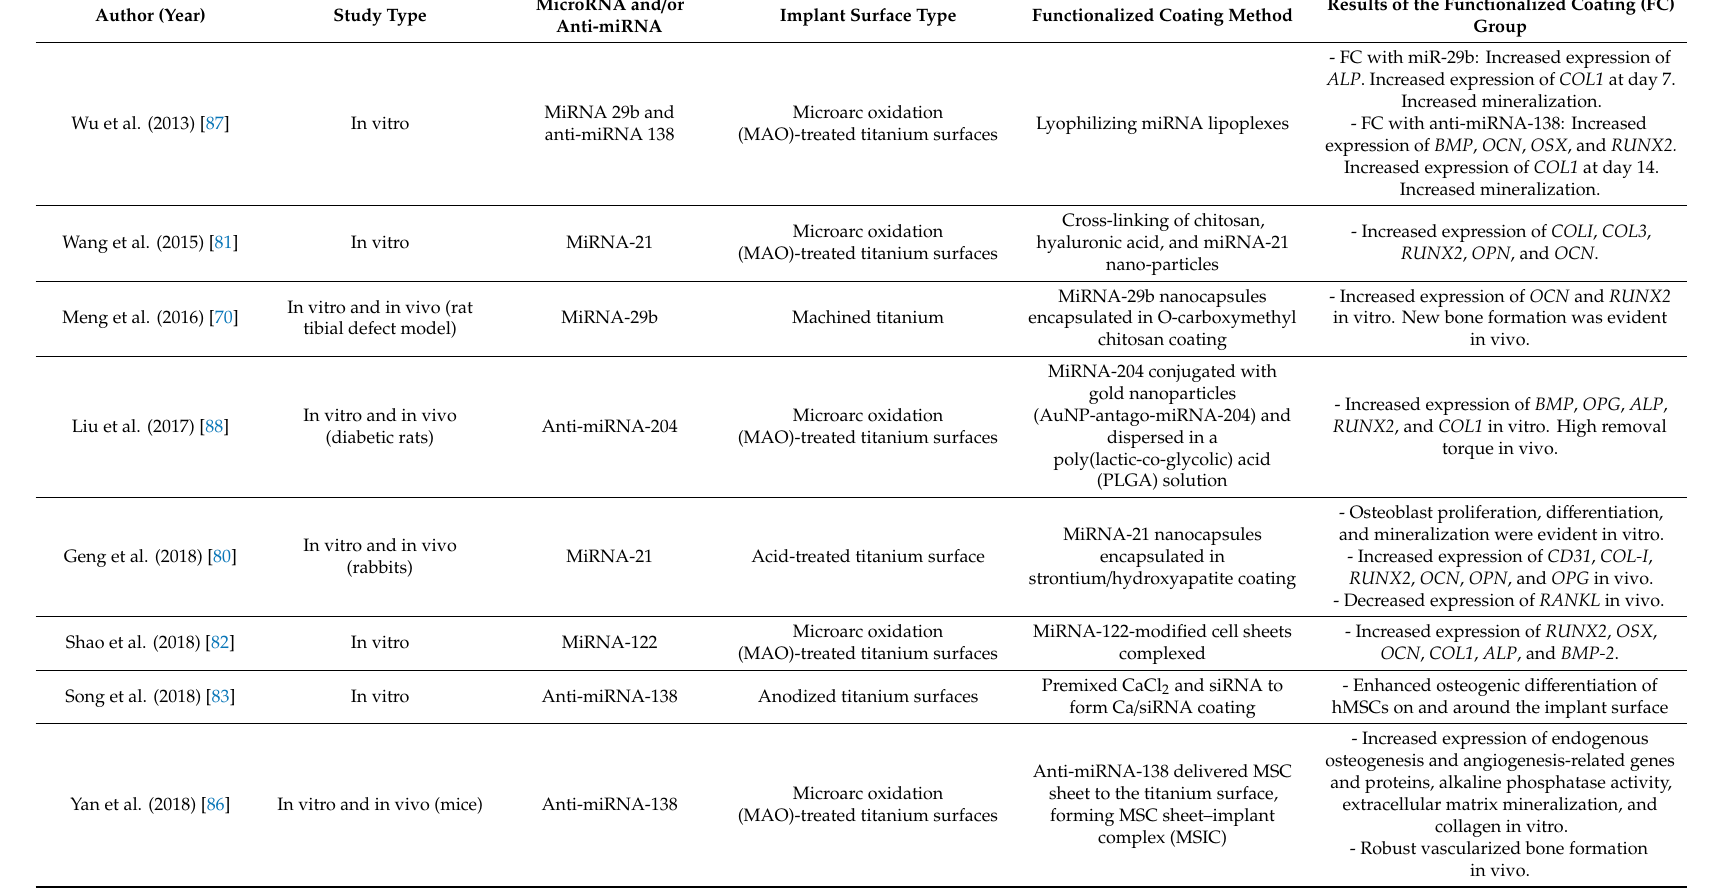
Table 1. Summary of studies on functionalized implant surfaces with miRNAs or